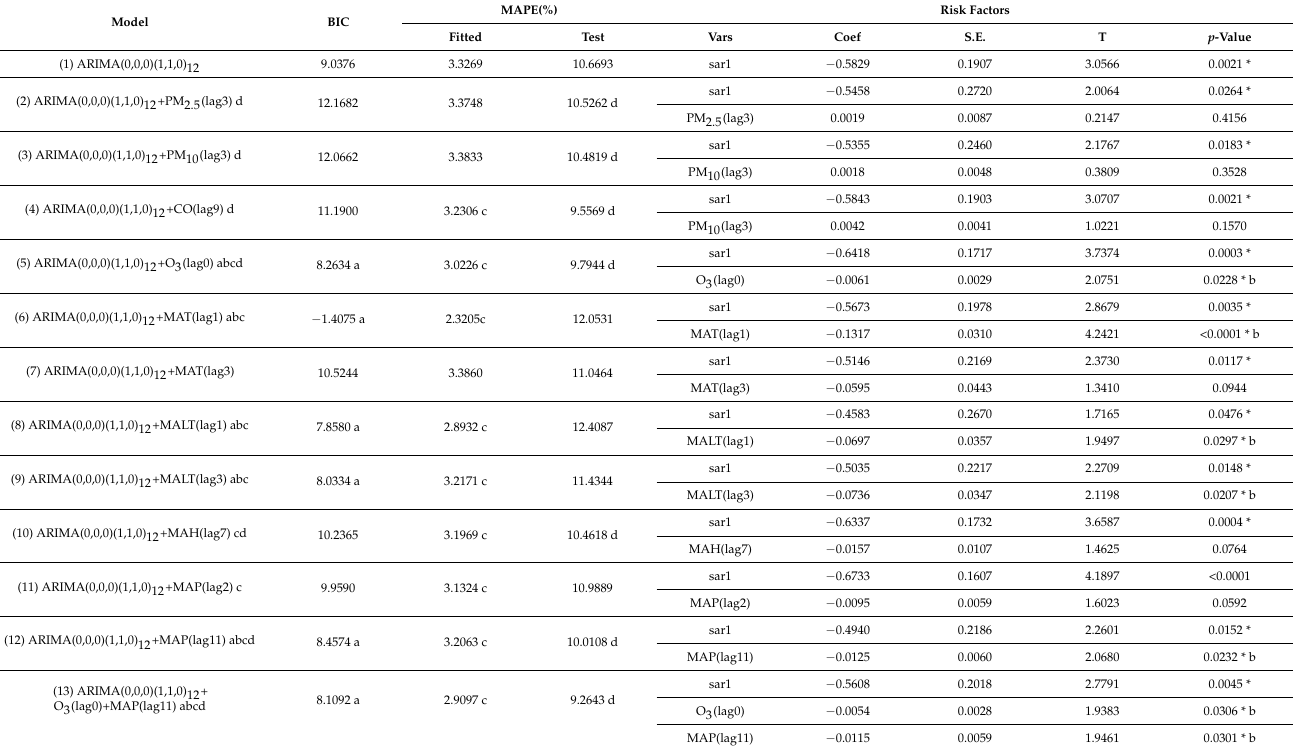
Table 5. Summary of the fitted parameters of the optimal ARIMA, univariate ARIMAX, and the multivariate ARIMAX model analysis in Ningbo,